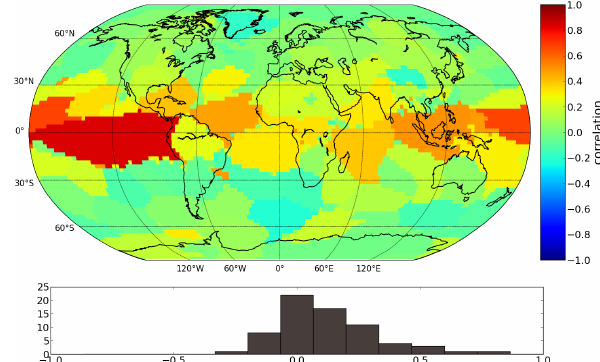
Fig. 4. Regions that show high relevance for the global graph evo- lution. Top panel: correlation of the intra-regional threshold evolu- tion with the global 2562-node network threshold evolution. Bottom panel: histogram thereof.